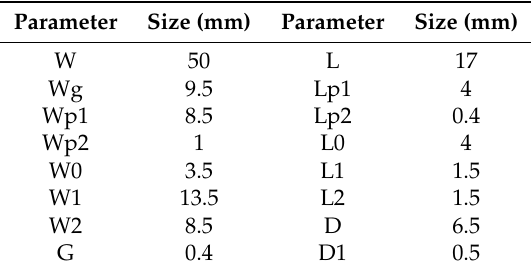
Figure 2. Antenna configuration with dimensions. Table 2. Dimensions of the Proposed Antenna.